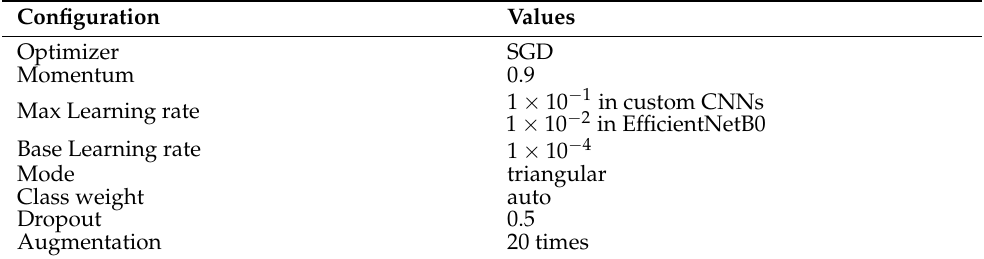
Table 8. The hyperparameter configuration of CNNs.